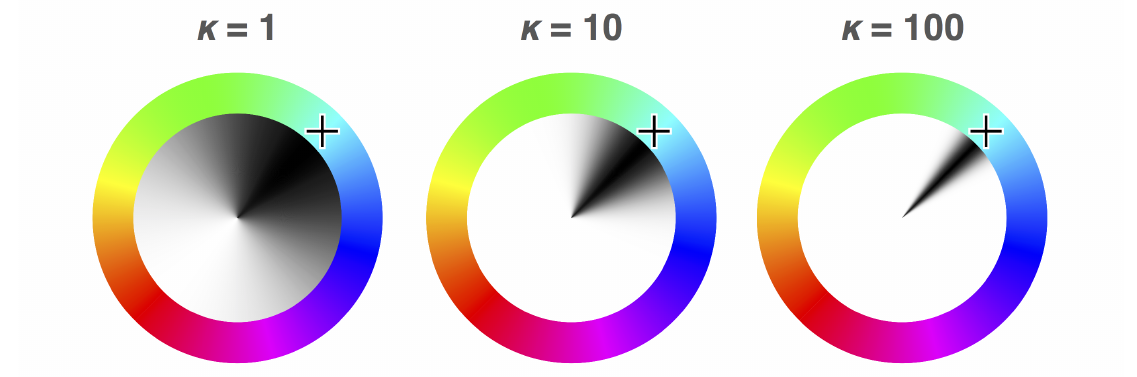
Figure 2. The theoretical distributions of responses on the colour wheel for low, high, and very high fidelities (from left to right), with the densities of the distributions indicated by the shading inside the colour wheels. The concentration of responses around the colour indicated by the cross is indicated in units of kappa ( κ ) for each wheel, with higher κ values indicating lower variance in